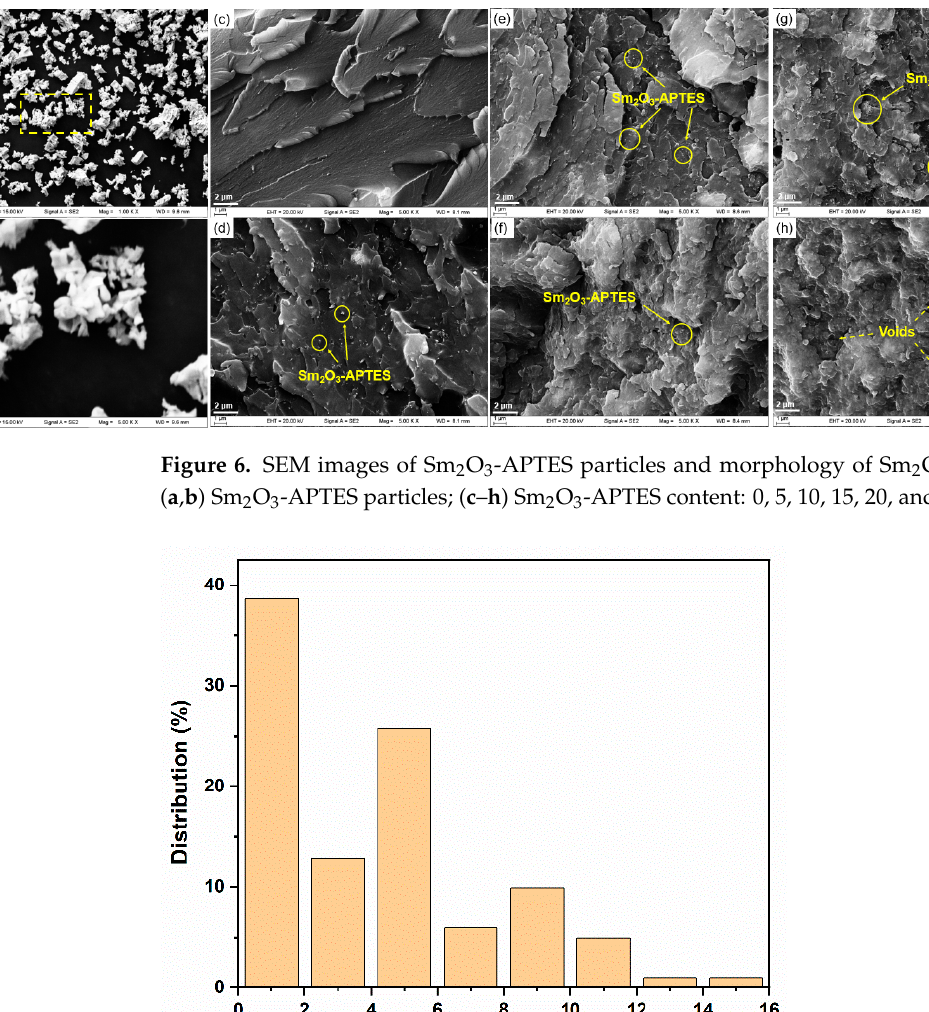
during the preparation process. In addition, the particle size distribution is shown in Figure 7. The average size of Sm 2 O 3 -APTES was approximately 1.16 µ m. Sm 2 O 3 -APTES particles of micrometer size can have a pinning effect on the epoxy resin matrix, which will be described in detail in Section 3.5.